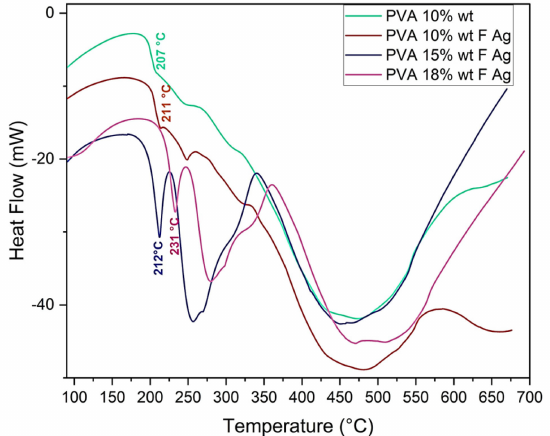
Figure 7. DSC of PVA 10% wt pristine and PVA 10%, 15%, and 18% wt/SF/Ag-NPs composite